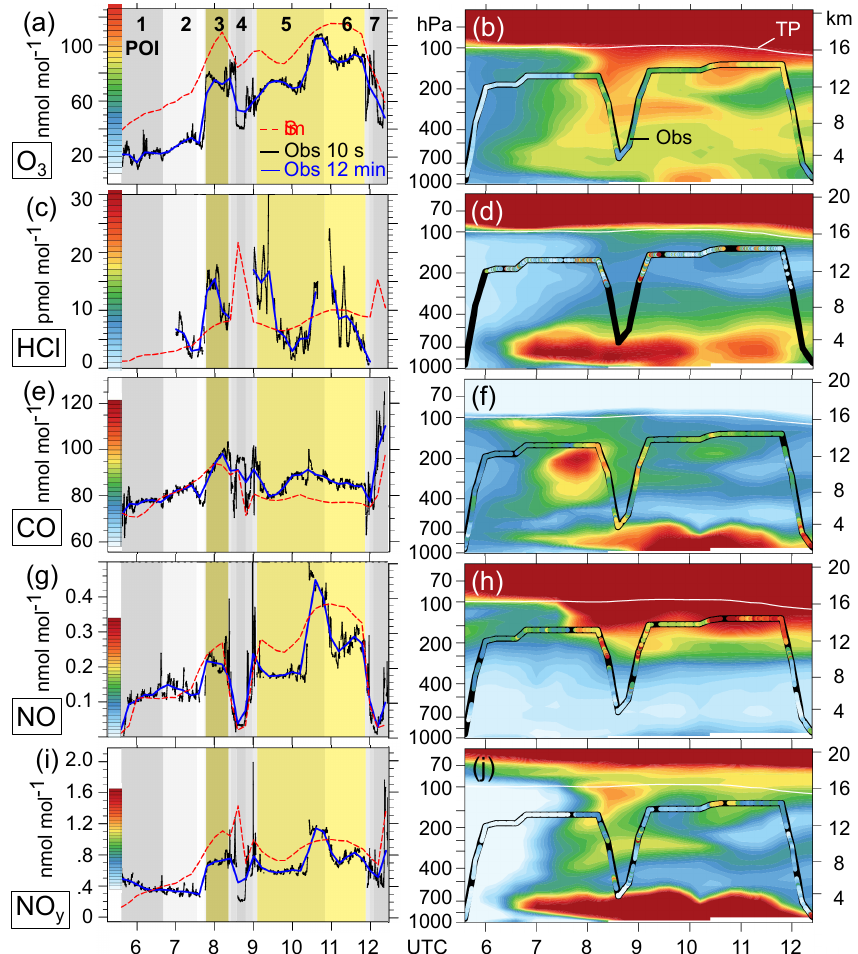
Figure 1. The left panel shows mixing ratios of O 3 , HCl, CO, NO and NO y along the HALO flight track from Male to Larnaca on 18 September 2012. Black: in situ measurements in 10s resolution, Blue: interval averages of the in situ data, corresponding to 12min simulation time steps, Red: simulation results. Yellow shadings mark the periods of interest, see text. Corresponding curtains simulated with EMAC along the flight track are shown on the right. The pipe follows the HALO flight altitude, filled with measured trace gas mixing ratios in the same colour coding (legends integrated in corresponding left panels). Black = missing. A thin white line indicates the simulated